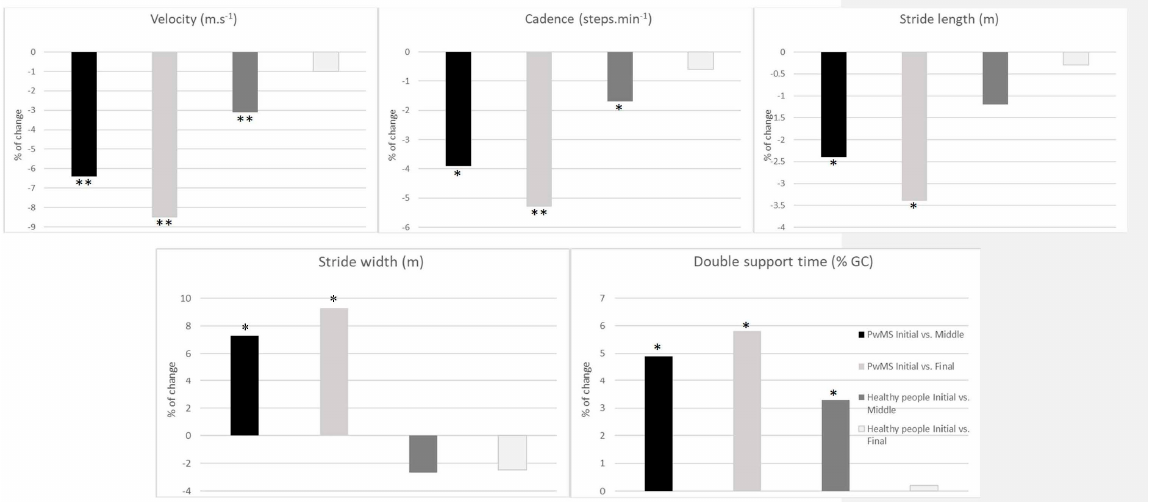
Figure 2. Changes between middle/initial and final/initial intervals in each group (e.g., PwMS and healthy groups). * < 0.01, ** < 0.001 significant difference in changes for the same group. GC, Gait Cycle.